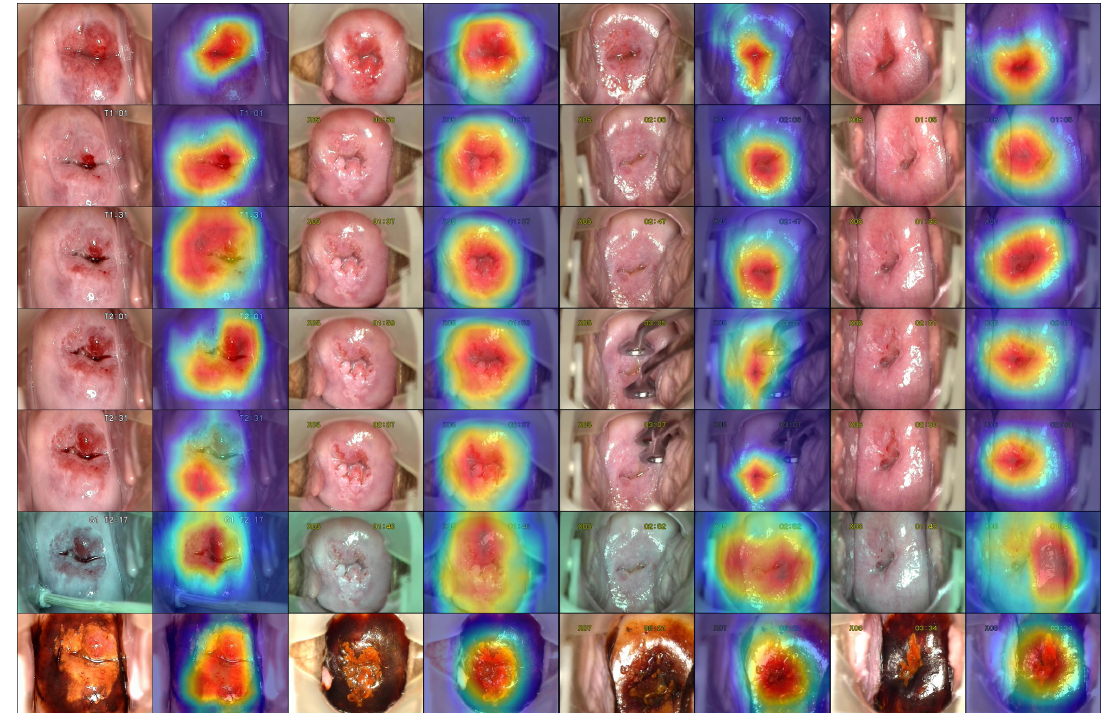
Figure 10. The network activations computed with GradCAM++[45] on the last convolutional layer of each network composing the ensemble. We partitioned this image into four columns, each containing the input of a single ensemble run and the corresponding activation heat maps. As can be noted, most of the time, the system looks at the relevant portions of the image, disregarding the noise. It does not pick up the text displayed by the camera, and it also does not take into account the cotton bud, nor the medical device displayed in Columns 1 and 3. In Columns 3 and 4, on the green lens images, the system gets distracted by the vaginal walls and by the light reflections, which could have a negative impact; even so, the majority of the images seem to be robust to these problems. The image was created by the authors from the dataset samples available at [33]. The source code presented in the Supplementary Materials covers the functionality for creating such